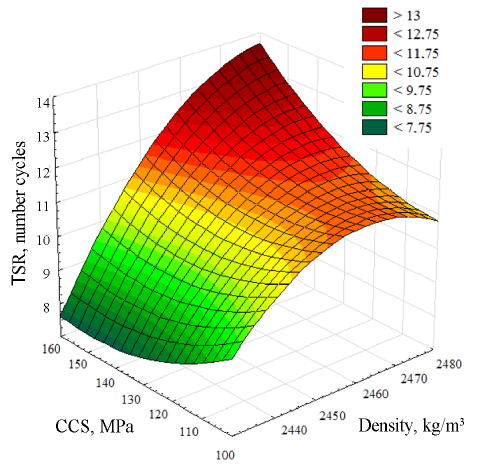
Fig. 7. Dependence of cold crushing strength and density on thermal shock resistance of refractory castable samples after heating at a temperature 950 °C